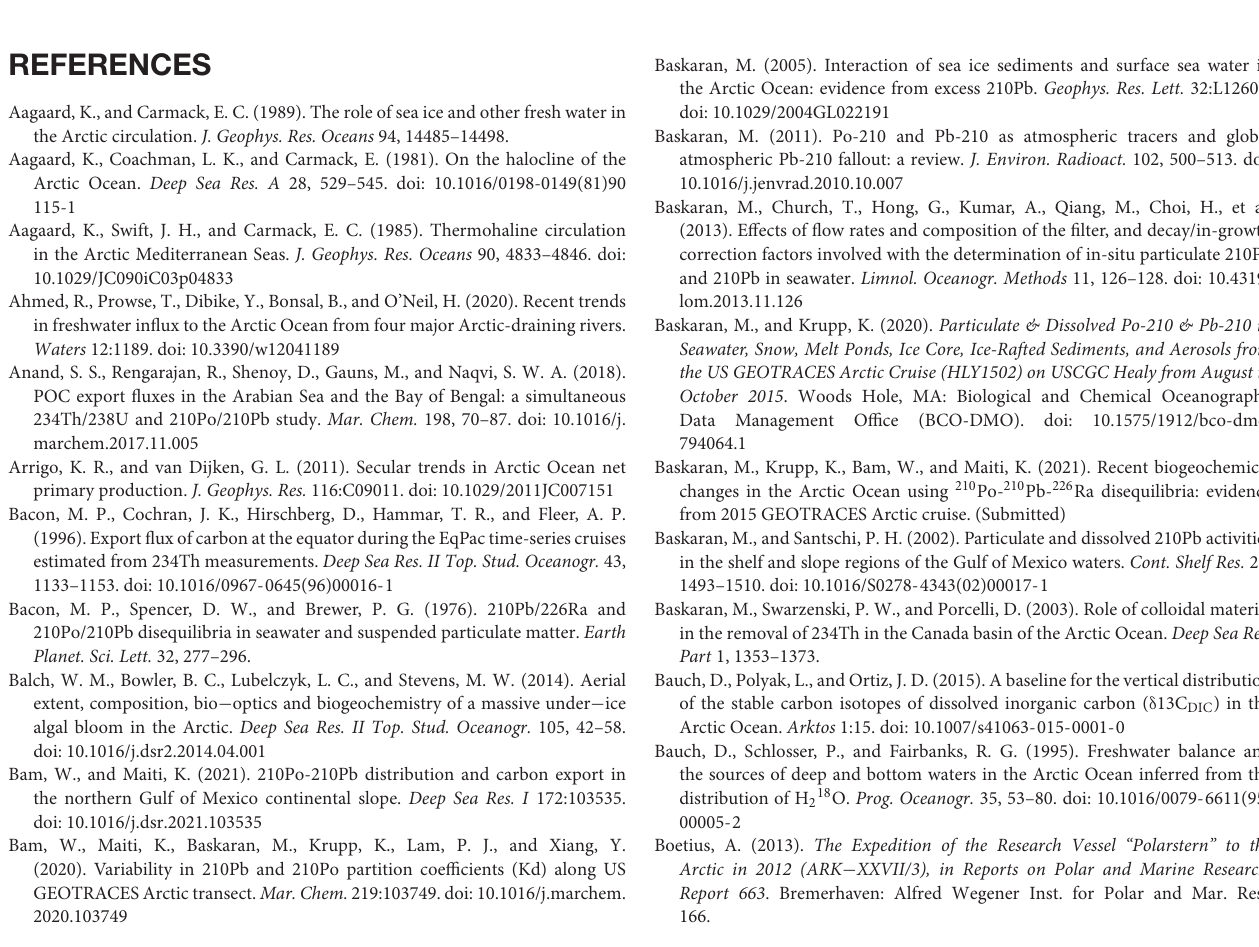
Supplementary Figure 1 | Water column CTD profiles showing Salinity [%], Fluorescence (0- 5 VDC volts), and Dissolved Oxygen [mg L − 1 ] for all the sampling station. The fluorescence has been magnified 100 times to show on the same x-scale. The top X -axis represents the salinity and fluorescence, and the bottom X -axis represents the dissolved oxygen. Supplementary Figure 2 | The activity depth profile of particulate (large and small) 210 Po (open circle) and 210 Pb (filled circle) for the sampling station in the upper 300 m. Supplementary Figure 3 | POC, PIC, PN, and bSi concentration on the large particle samples for upper 300 m water column depth. Supplementary Table 1 | POC fluxes in large and small particle fraction sizes using 210 Po flux. Supplementary Table 2 | PN fluxes in large and small particles fraction sizes using 210 Po flux. Supplementary Table 3 | PIC flux estimated based on the 210 Pb and 210 Po fluxes in large